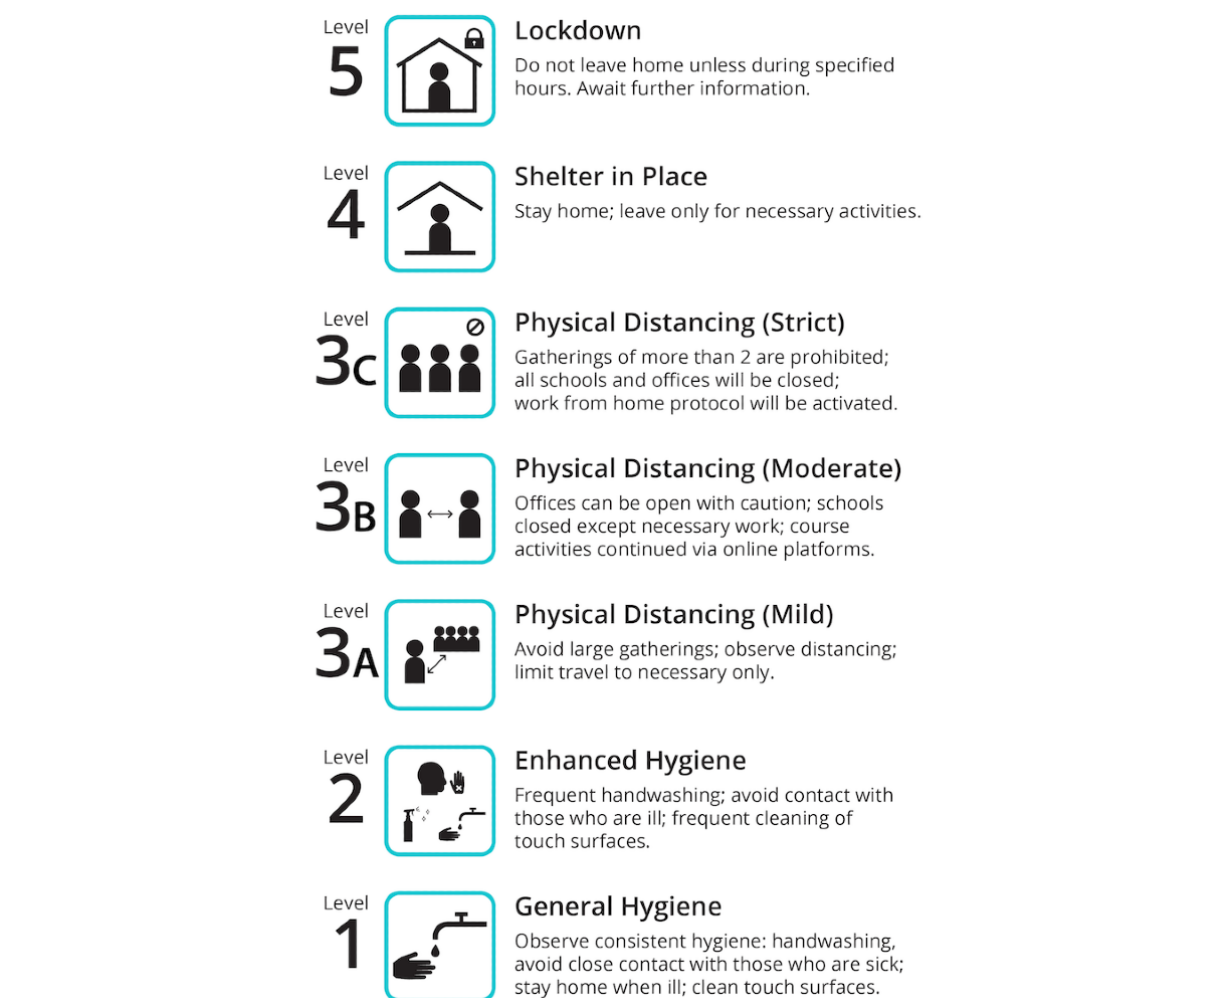
Figure 1. Sample icon and instruction set for a pandemic alert and response notification